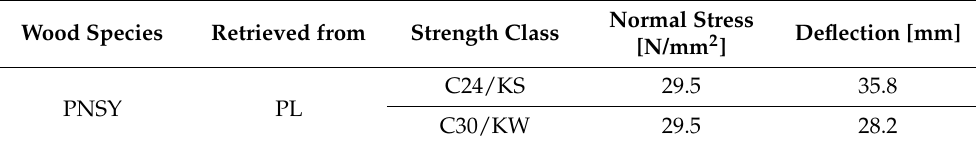
Table 12. Normal stresses and deflection (displacement) of long frames in version B made of glued material with a finger-jointed lamella length of 200 mm (pine, country of origin: Poland).